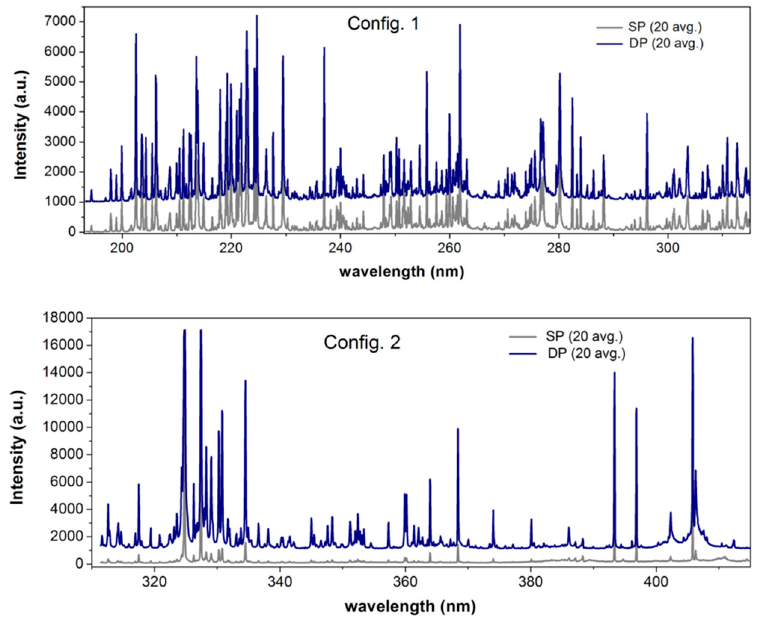
Figure 4. Comparison of SP and DP LIPS spectra of a bronze sample in the two studied configurations. DP spectra have been vertically shifted (1000 units) for better visualization. Acquisition delay of 1.3 µs, integration time of 2 ms, SP ( ε sp = 90 mJ), config. 1 DP ( ε p2 = ε p1 = 85 mJ, Δτ p = 85 µs), config. 2 DP ( ε p2 = 2 ε p1 = 100 mJ, Δτ p = 90 µs).